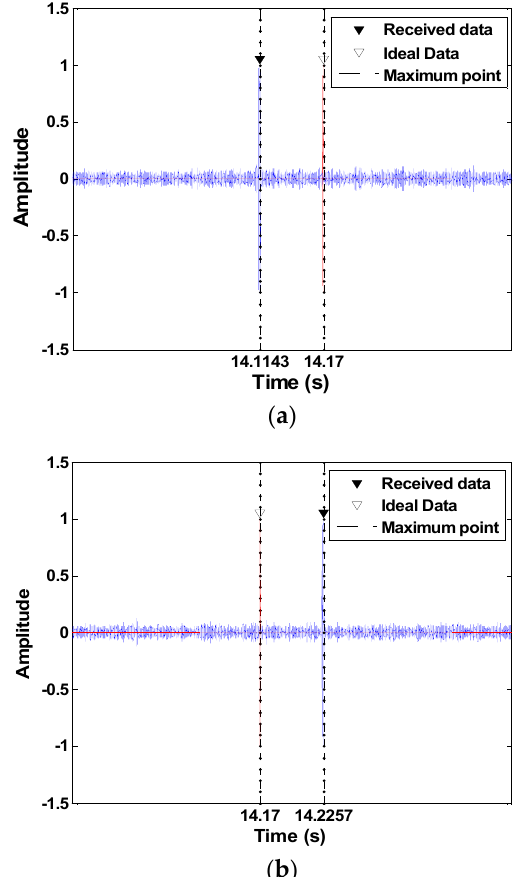
Figure 11. Matched filtering output for the received data and the ideal data. ( a ) The approach; ( b ) the retreat.